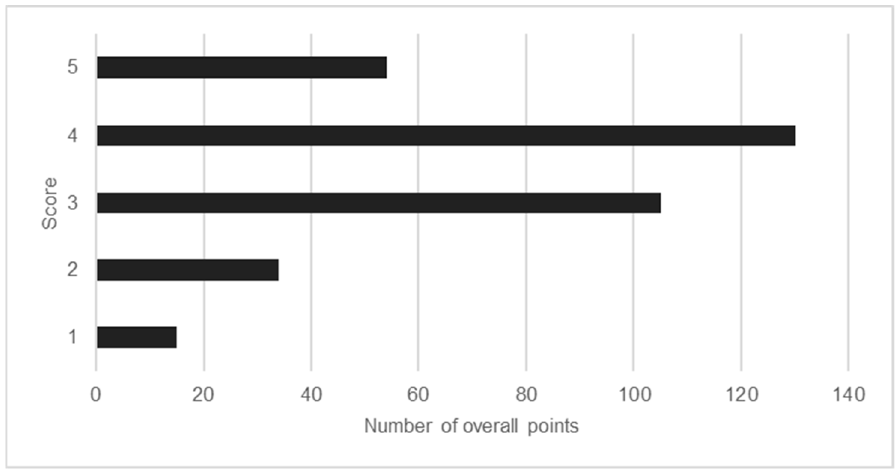
Figure 5. Total score distribution over all questions and companies.